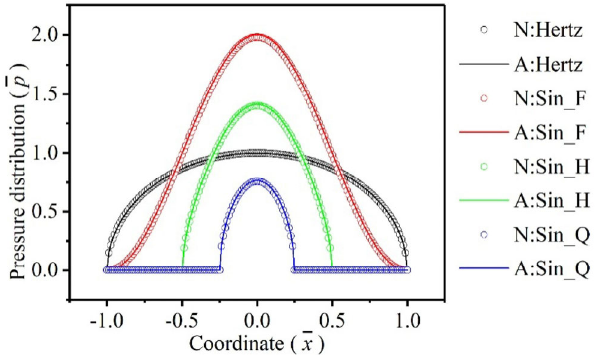
Fig. 3 Validation of the current numerical results with